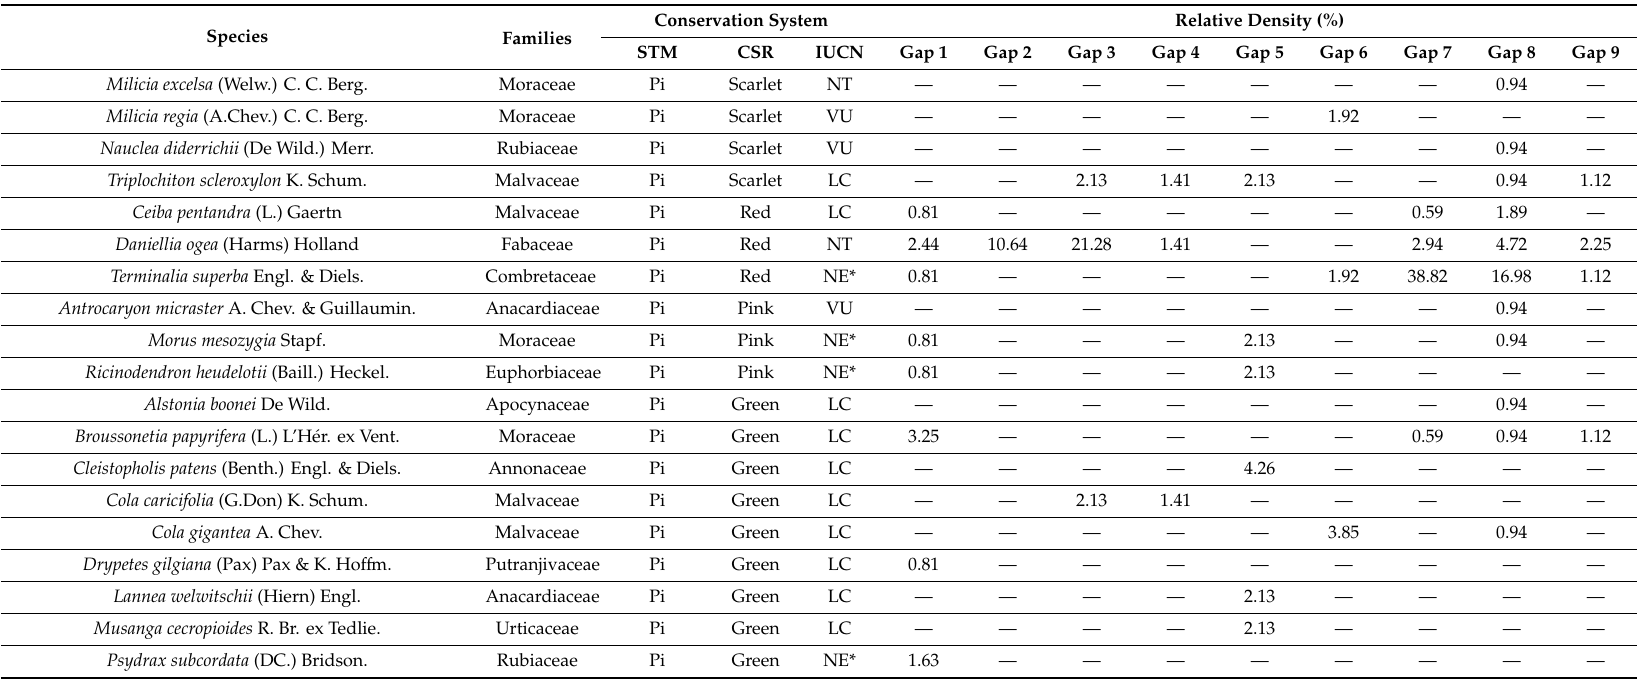
Table 1. Composition of natural regeneration tree species in di ff erent gaps at Bia Tano Forest Reserve of Ghana. The abundance of individual species within each gap is presented by their relative densities. Columns show species names with authors, including their assigned taxonomic families [40]. Shade tolerance mechanism (STM) of species including Pi—Pioneers, NPLD—Nonpioneer light-demanding species and SB—Shade bearers as well as their conservation status in Ghana by standardized Conservation Star Ratings (CSR) showing Green Star (species with no particular conservation priority), Pink Star (species with low particular conservation priority), Red Star (species with some conservation priority) and Scarlet Star (species with high conservation priority) (order of increasing conservation concern) [30] and globally by LC—Least Concern species, NT—Near Threatened species and VU—Vulnerable species (increasing order of extinction risk) under International Union for Conservation of Nature Red List of Threatened Species ™ (IUCN Red List) [41] alongside NE*—Not Evaluated ( NE ) not enlisted Red List species. Absence of species indicated by